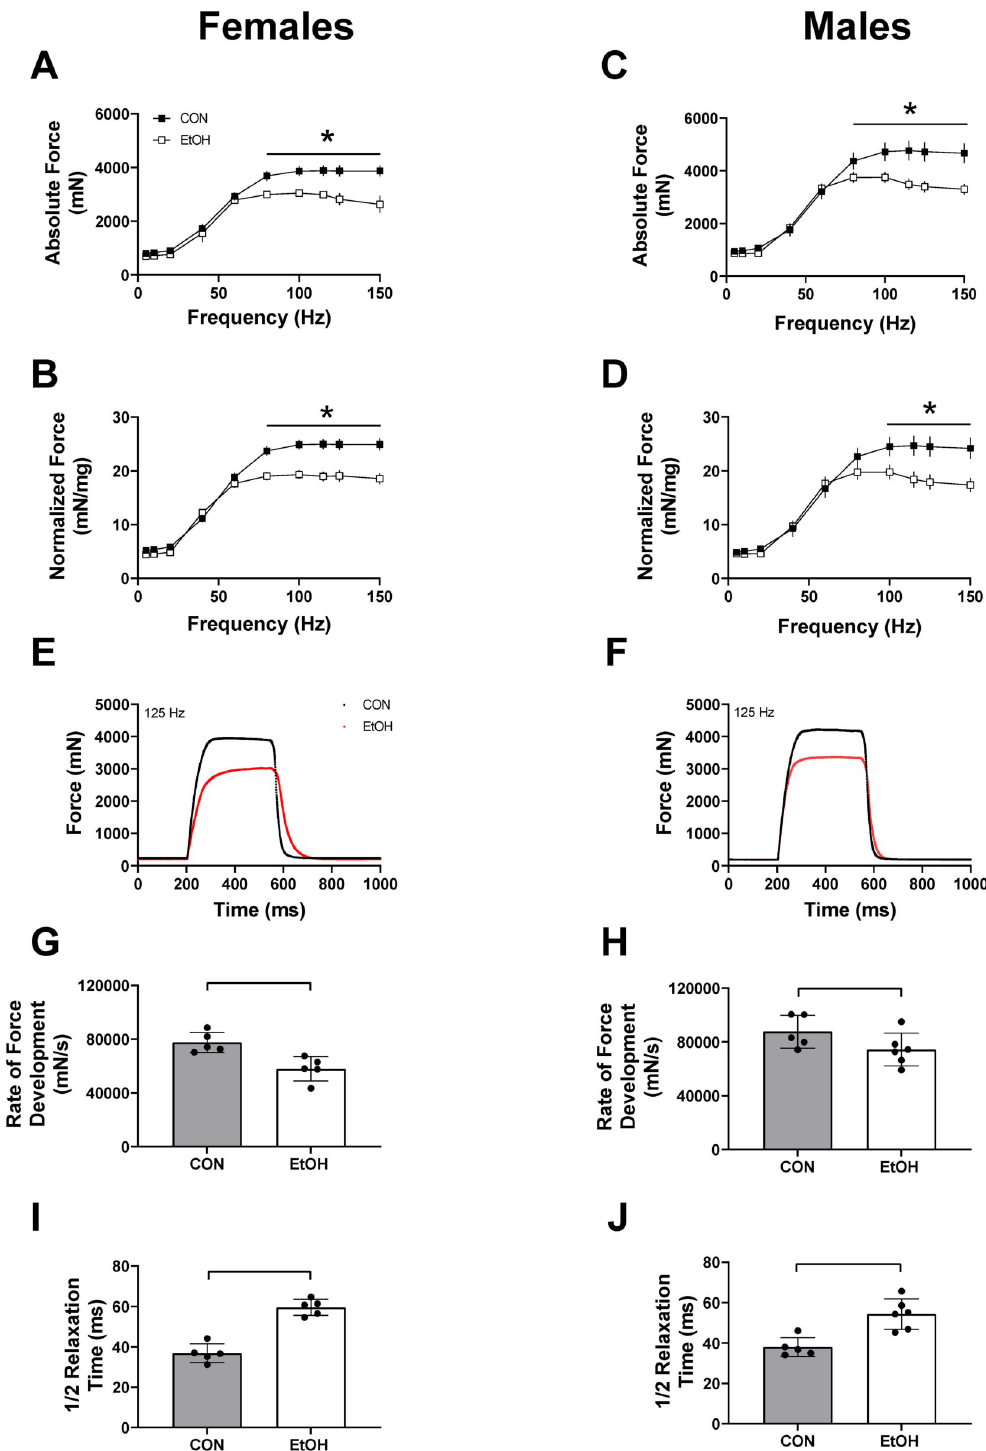
Fig 1. Effects of 1 hour of alcohol intoxication on skeletal muscle force in male and female mice. Absolute force (mN) and force normalized to triceps surae muscle complex weight (mN/mg) during the force frequency protocol at 1 hour for Control (CON) females (n = 5) and Alcohol (EtOH) females (n = 5) (A and B), as well as Control (CON) males (n = 5) and Alcohol (EtOH) males (n = 6) (C and D). Two-way repeated measures ANOVA was used to detected differences between control and alcohol within each sex. Panel A, p = 0.0041; Panel B, p < 0.0001; Panel C, P < 0.0001, Panel D, p < 0.0001.